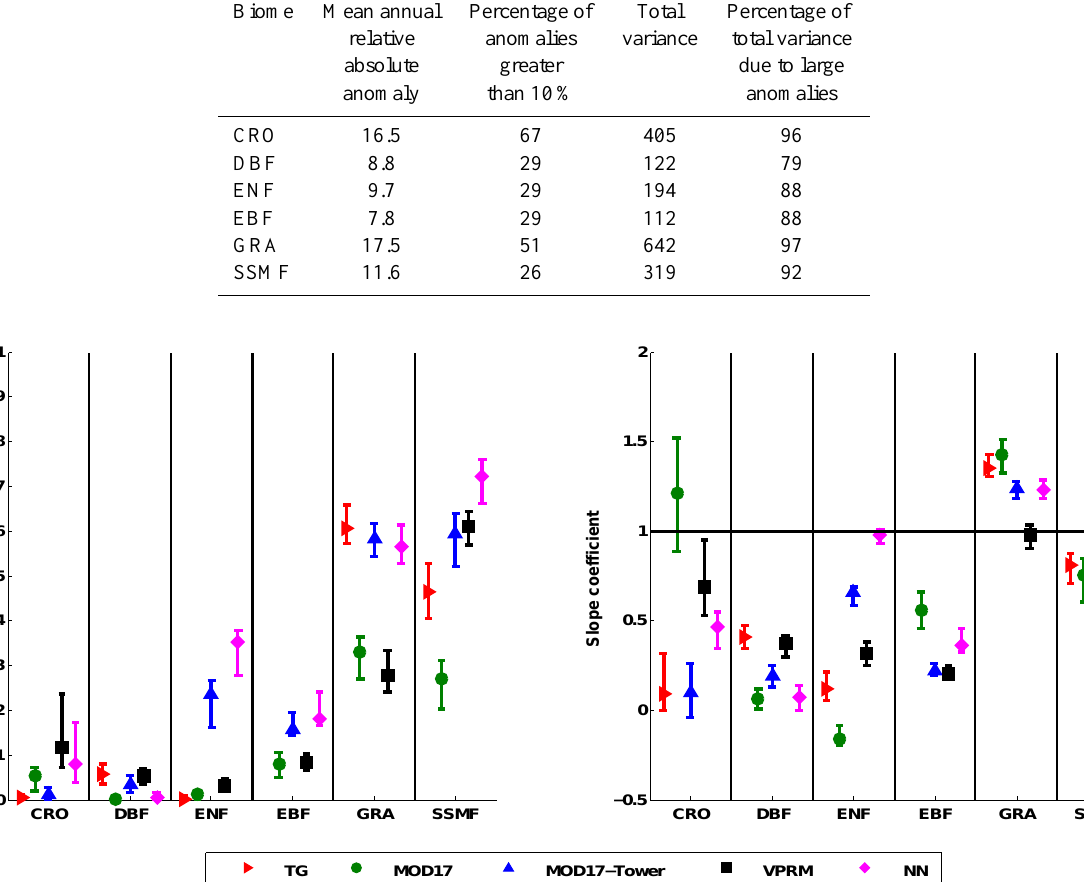
over large areas. However, whether and how leaf level